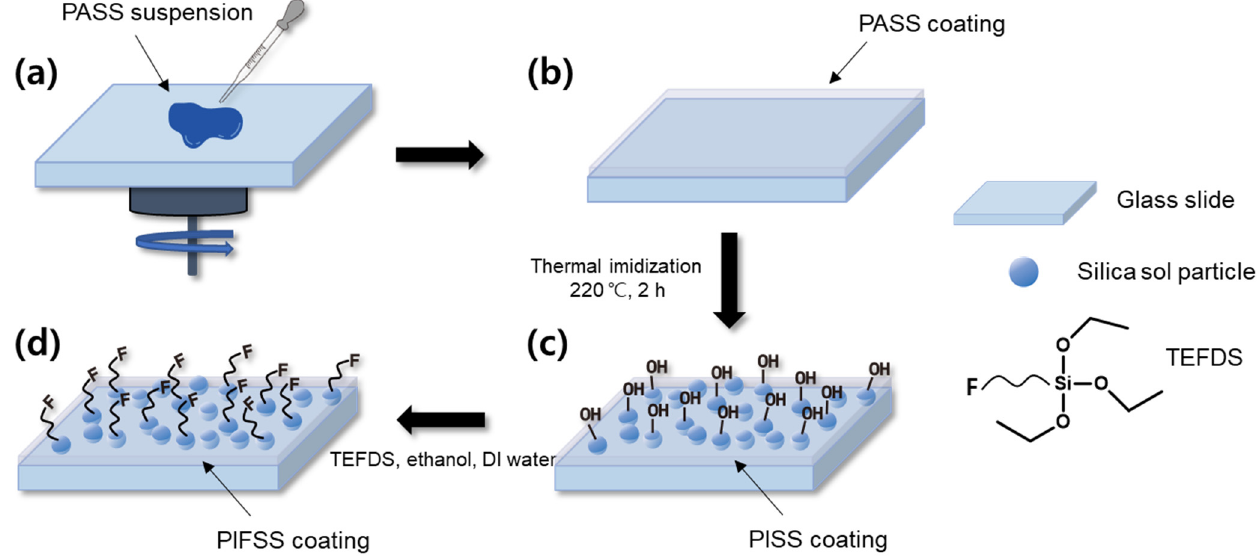
Figure 2. Preparation of self-cleaning PIFSS coatings: ( a ) spin-coating of a PASS suspension on a glass slide, ( b ) PASS coating on the glass slide, ( c ) PISS coating prepared by thermal imidization, and ( d ) PIFSS coating prepared by condensation reaction of hydroxyl groups with hydrolyzed TEFDS.